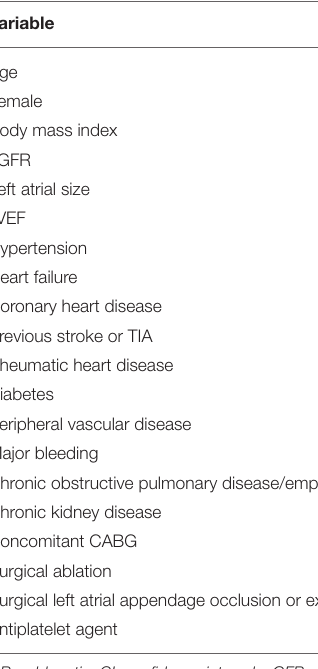
TABLE 5 | The factors related to the use of